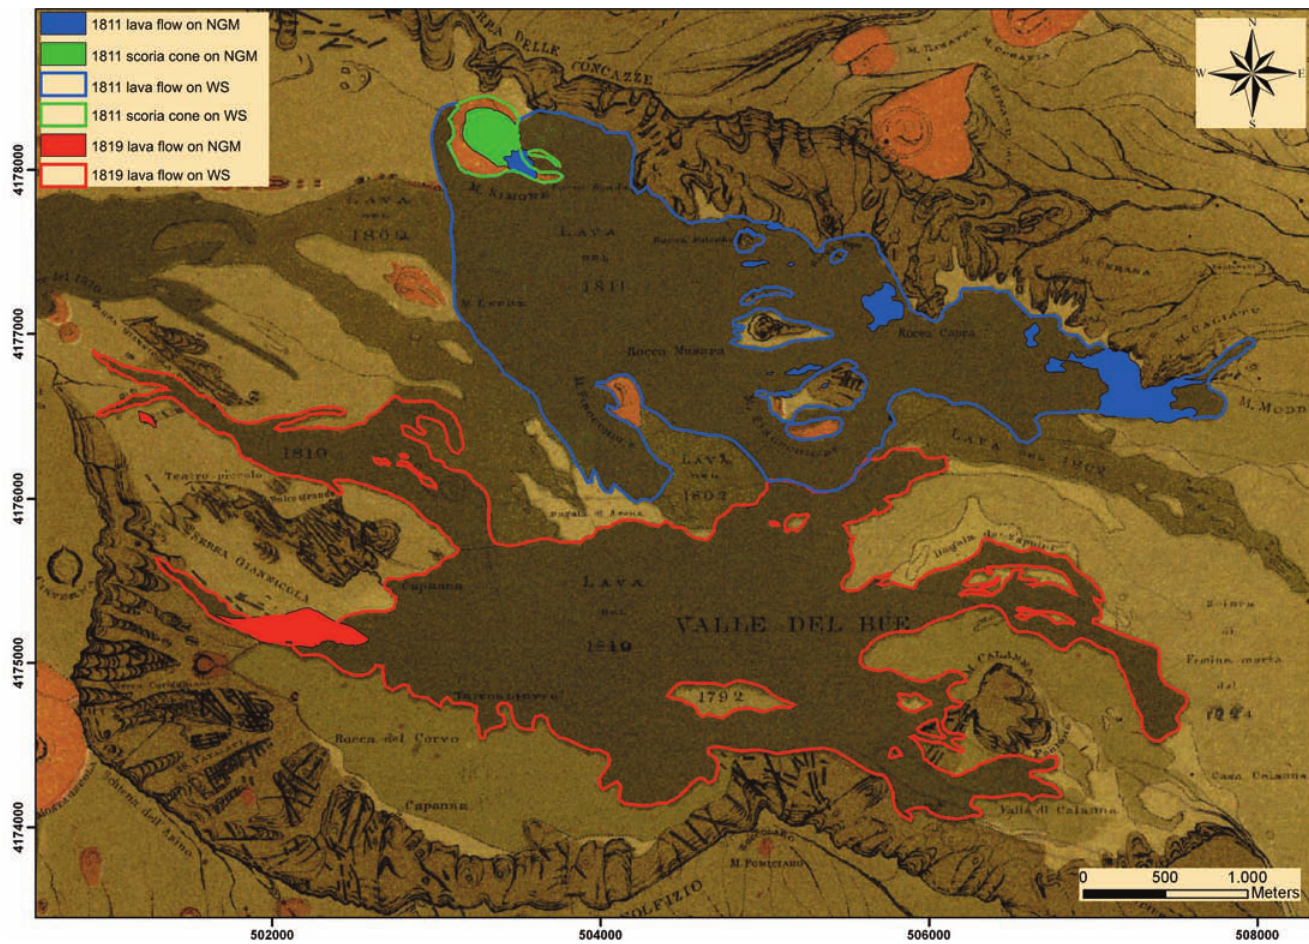
Figure 2. Example of delimitation on the Waltershausen [1845-59] geological map of lava flow fields that are widely hidden on the NGM. The limits of the 1811 and 1819 flow fields defined on the Waltershausen [1845-59] map are drawn as blue and red lines, respectively; the red and blue filled areas represent their portions outcropping on the NGM. Green lines and filled area define the 1811 scoria cone on the Waltershausen [1845-59] map and on the NGM, respectively.